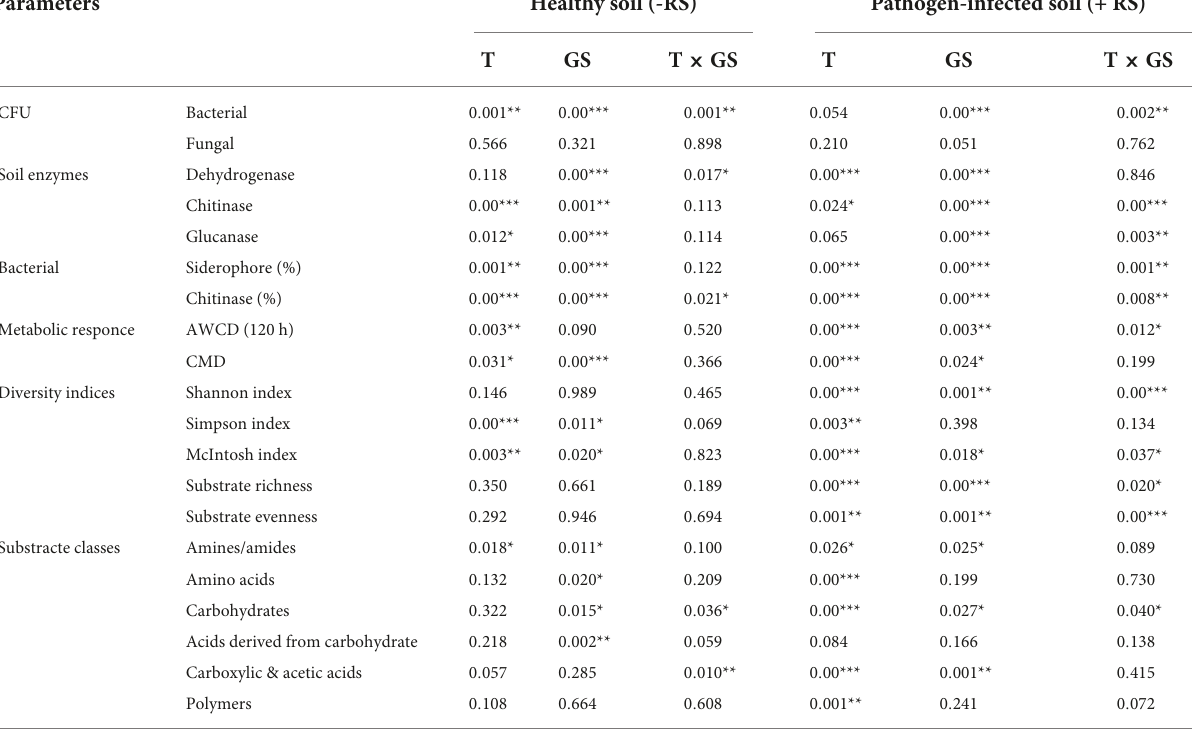
TABLE 1 The P -values of PERMANOVA for soil parameters, microbial count, diversity indices, and different classes of AWCD rate in R. solani infected and healthy soil.